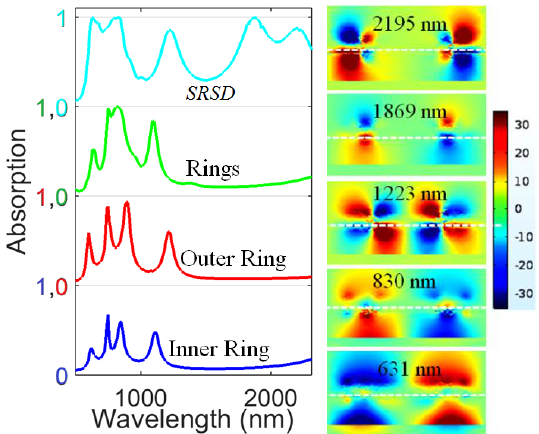
Figure 2. Absorption spectra of the inner ring, outer ring, two rings, and split rings + split disk (SRSD). The inset shows the electric field distribution of light normalized to the incident field at resonant wavelengths in the zx -plane intersecting the center of unit cell (y = 0) for the SRSD structure. The white dotted line demonstrates the interface of resonator and substrate.